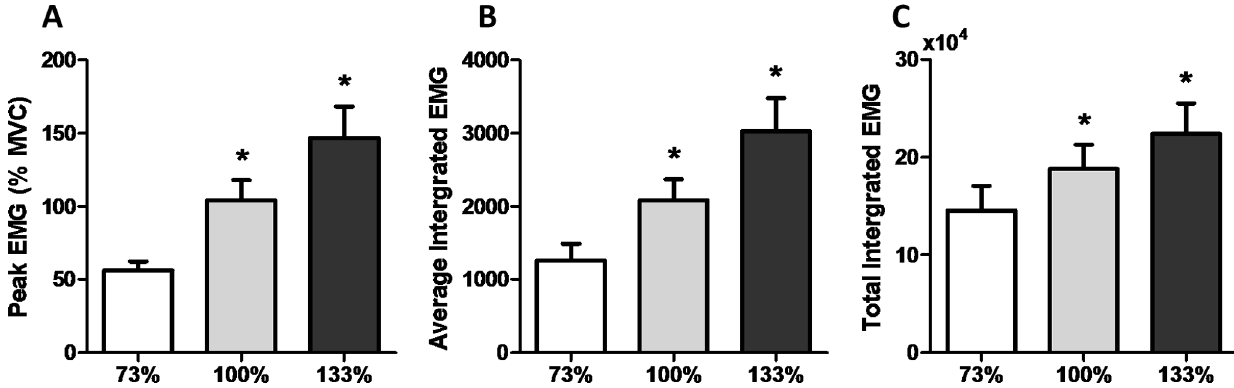
Figure 1. EMG derived estimates of muscle activation during high-intensity interval exercise. Muscle activation, assessed by average peak pedal stroke EMG signal (A), integrated EMG signal averaged per 60 second interval (B), and total integrated EMG signal (C). * Significantly ( p , 0.05) different from 73%.